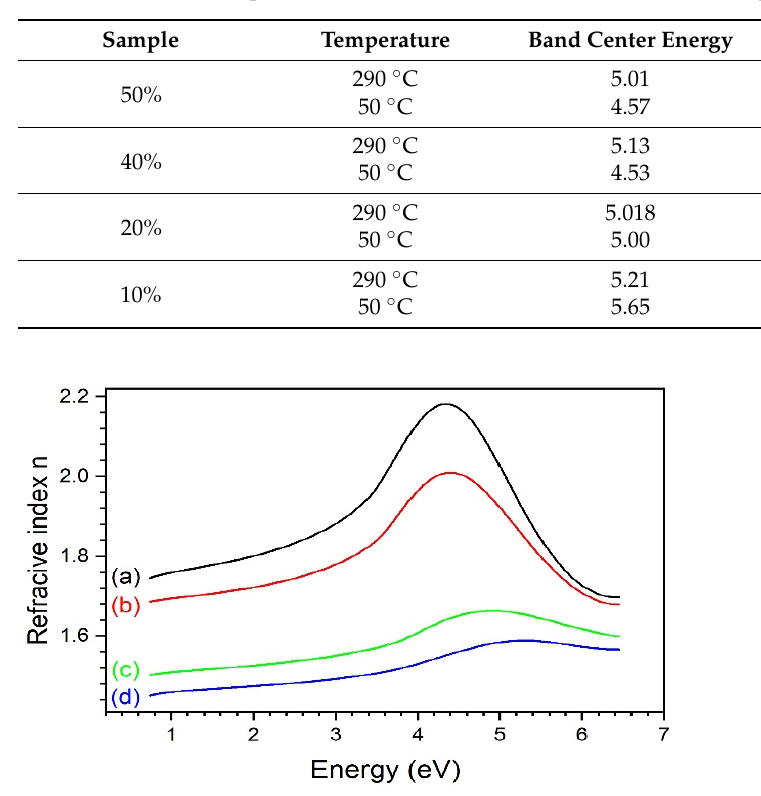
Figure 10. Refractive indices derived within the framework of Tauc–Lorentz model for samples 50%—(a), 40%—(b), 20%—(c), 10%—(d) at 50 °C.